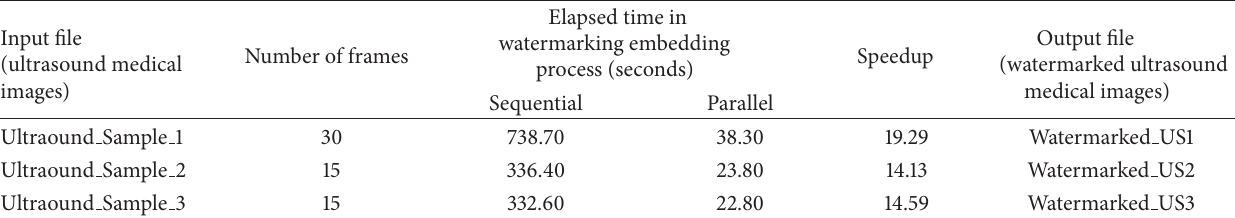
Table 6: Sequential versus parallel watermarking embedding process in elapsed